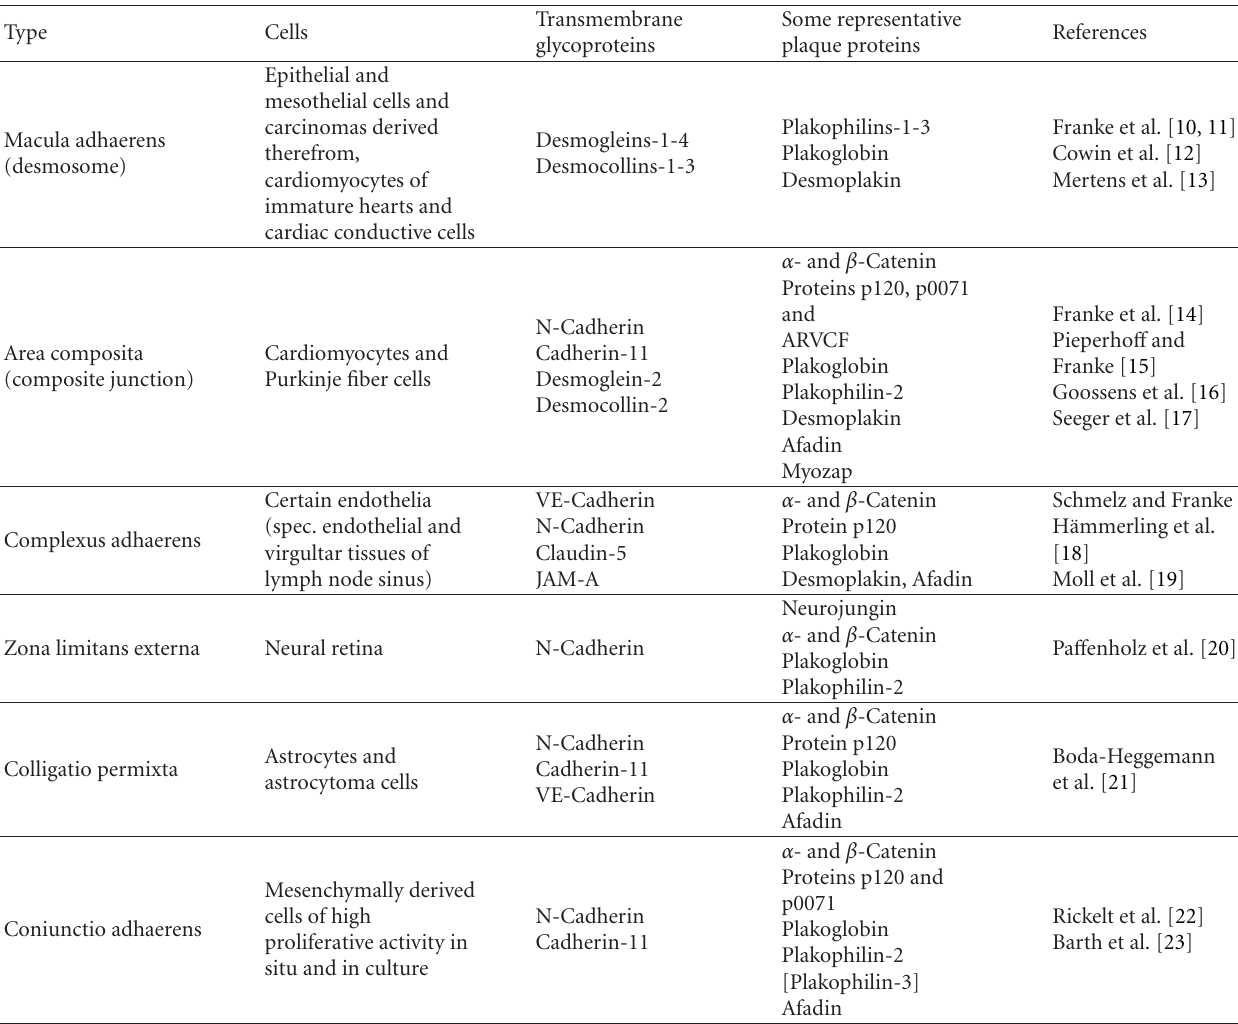
Table 1: Shown are specific cell-cell adhering junctions containing transmembrane glycoproteins and cytoplasmic plaque proteins of “classic” desmosomes and adherens junctions (AJs). Special types of adhering junctions containing desmosomal proteins in human tissues and cell